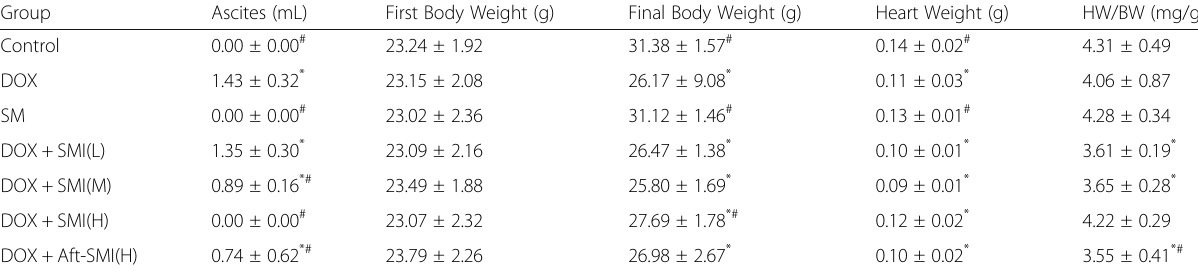
Table 1 Effect of SMI and / or DOX treatment on animal characteristics Group Ascites (mL)